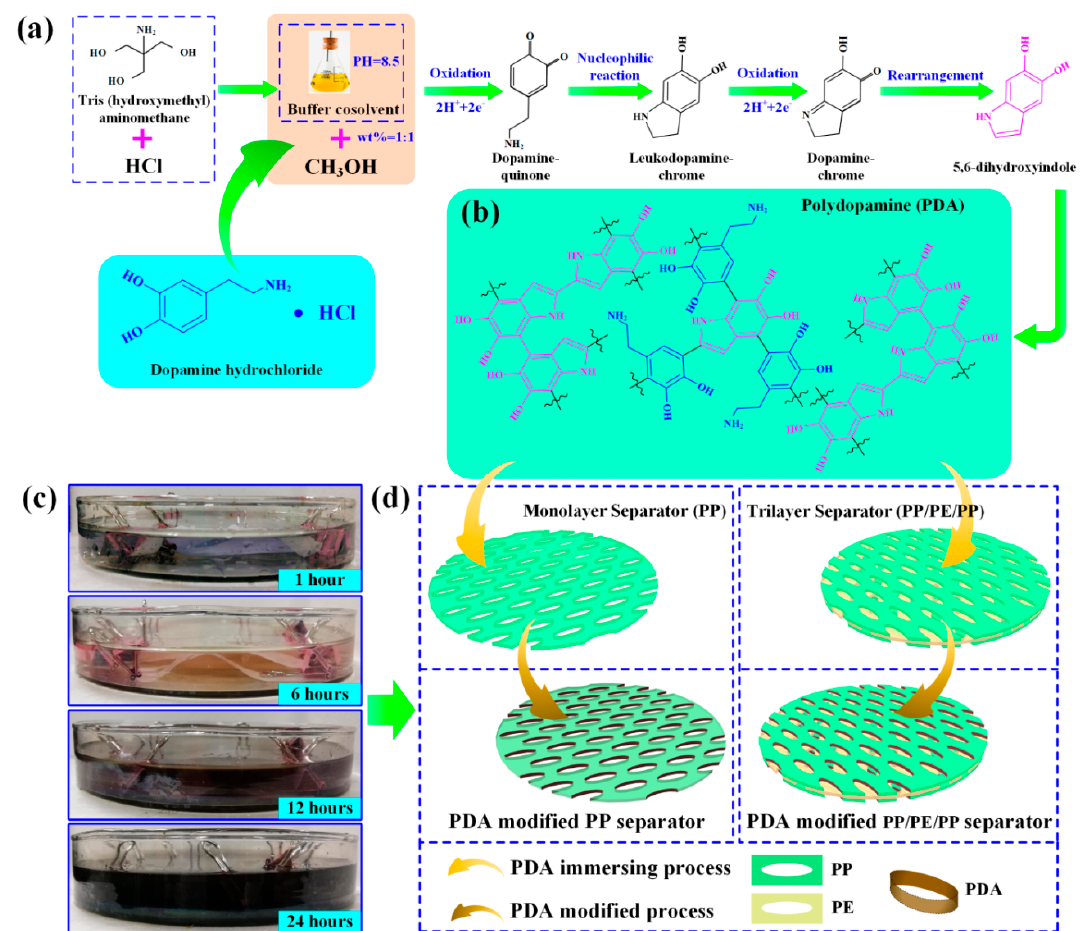
Figure 1. Schematic and preparation of the polydopamine(PDA)-modified separator: ( a ) dopamine polymerization mechanism for PDA; ( b ) chemical structure of PDA; ( c ) images of the PDA-modified separator and dopamine solution change over dipping time; ( d ) schematic illustration of the PDA-modified separator process by immersing method.